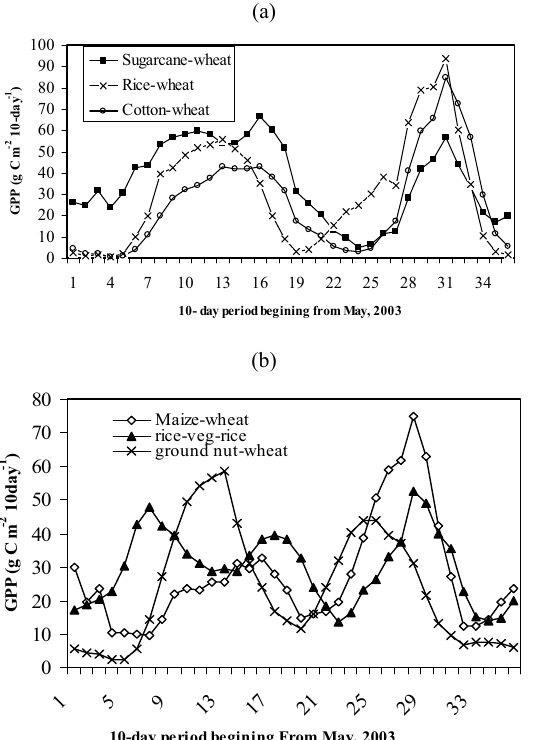
Fig. 2 Temporal variation in GPP over major cropping during 2003-04 growing season in India 3.3 Temporal pattern of mean cropland NPP Fig.1. Spatial pattern of annual primary productivity over cropland in India during 2003-04 from VPM Net primary productivity by area-weighted average over all cropland pixels for each 10-day period had distinct time-variation 3.2 Temporal pattern of GPP over major crop rotations over a growing season (Fig. 3). Time plot of NPP over a agricultural year illustrates that cropland ecosystem as a whole in Time-evolution of carbon uptake in agro-ecosystem differs from country have two distinct active growing season as reflected from natural ecosystems and is a key to understand influence of two peaks of NPP. The peaks were of same magnitude during phenology, environmental and cropping practice such as crop both kharif and rab i seasons. In initial dekads of dry summer in rotation and C4/C3 crop mixture. Henceforth, the time-series of May, the NPP was almost static and negligible. As the south-west modeled GPP on decadal time scale extracted for various crop monsoon commences, NPP increases rapidly following active rotation practiced dominantly in selected districts and presented in growth of crops in kharif season and attained a peak (25 g C m -2 figure 2a & b. Well managed agro-ecosystems in Trans-Gangetic 10day -1 ) in the first dekad of October, 2003. NPP then and upper Indo-Gangetic plains had two distinct peaks with